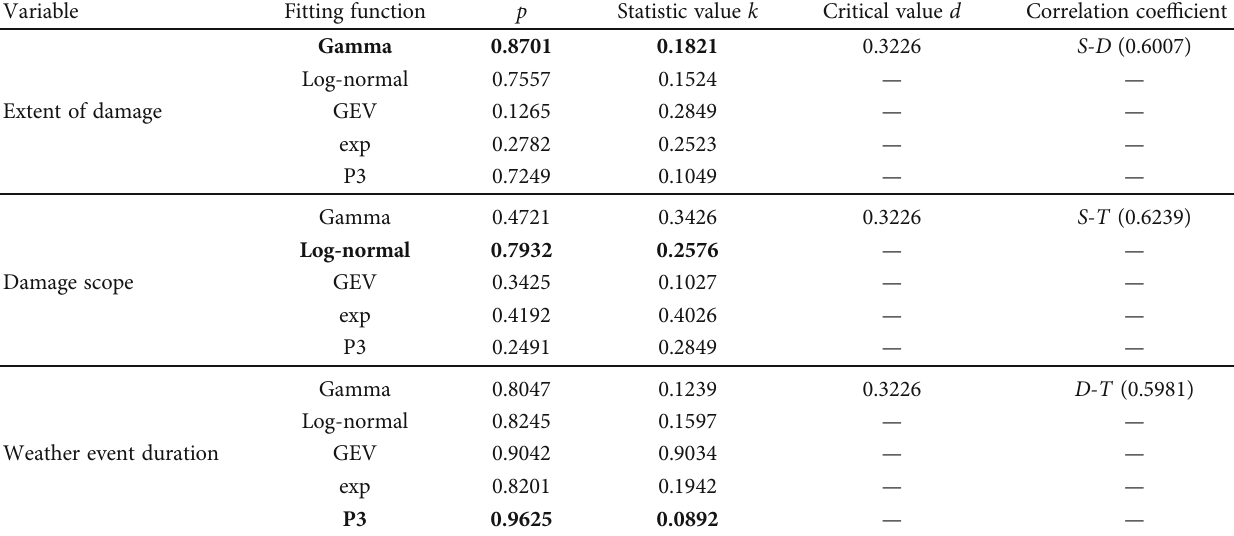
Table 1: Test statistics and correlation coe ffi cient of marginal distribution function.